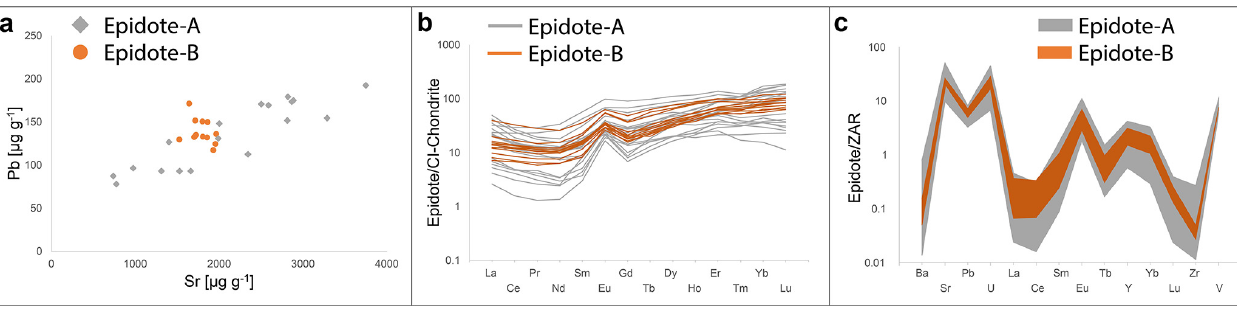
Figure 11. Epidote LA-ICP-MS data of (a) Pb and Sr mass fractions, (b) CI chondrite-normalized (McDonough and Sun, 1995) rare earth element (REE) patterns, and (c) mass fractions of selected trace elements in epidote normalized to the Central Aar Granite (ZAR; Schaltegger and Krähenbühl,